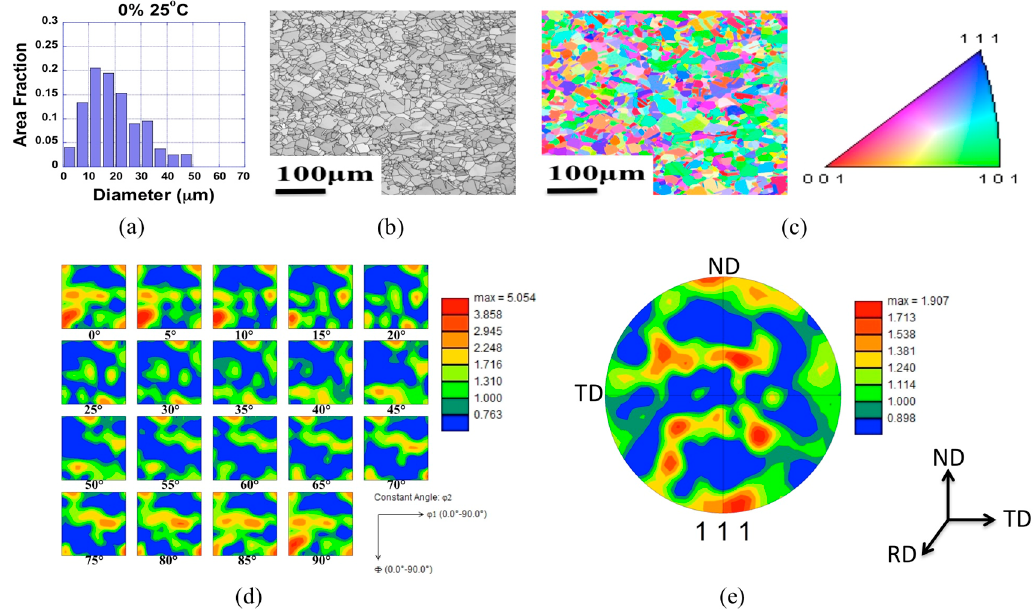
Figure 3. Baseline grain boundary metrics for unstrained, commercially pure Ni-200. ( a ) Grain area fraction distribution; ( b ) electron backscatter diffraction (EBSD) grain contrast map; ( c ) grain orientation map with inverse pole figure (IPF); ( d ) orientation distribution function map and ( e ) pole figure. (Orientations reported with respect to the rolling direction (RD), normal direction (ND) and transverse direction (TD) for ( c )–( e ); Adapted with permission from [19], © 2016 ASM International and Springer Science + Business Media New York, 2016.)